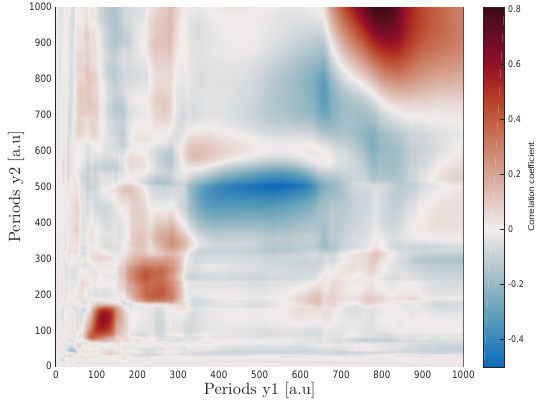
Figure 3. A 2D correlation map of sinusoidal (y1) and damped sinu- soidal (y2) signals, with matching period of 125 [a.u] and corrupted with random noise. The peak at lower left of the diagonal indicates period of 122 ± 26 [a.u]. Due to change in width of waves in damped sinusoid, periodic signals are not in perfect phase or antiphase which is indicated by presence of Nyquist period in the upper right corner and two weakly correlated islands in the middle (~250 [a.u] and ~500 [a.u]).